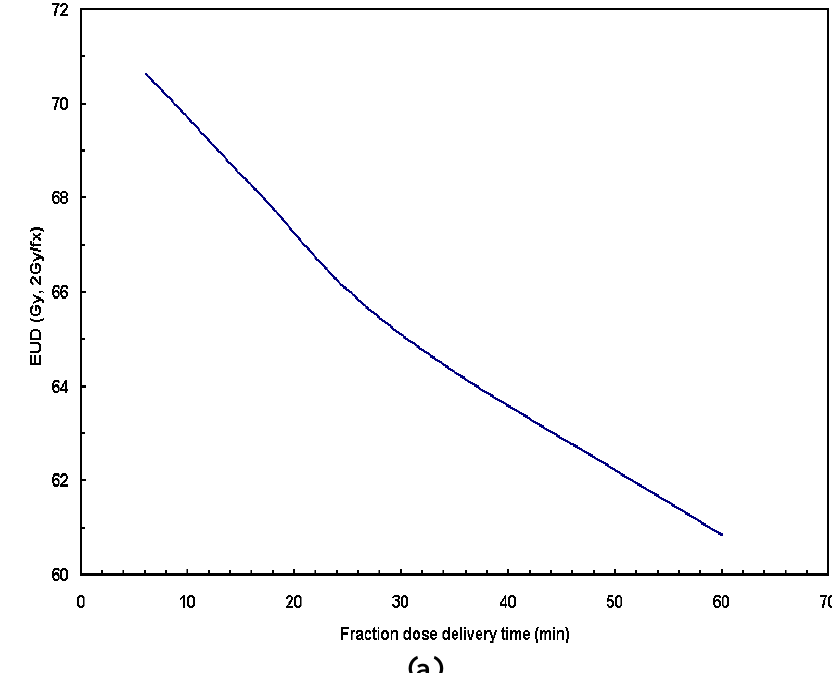
Figure 3. Influences of dose delivery time on ( a ) EUD and ( b ) TCP. The derived parameters: α / β = 8.3 ± 4.1 Gy, α = 0.22 ± 0.08 Gy − 1 and repair halftime T the potential doubling time T = 4.0 ± 1.8 days were used in the d